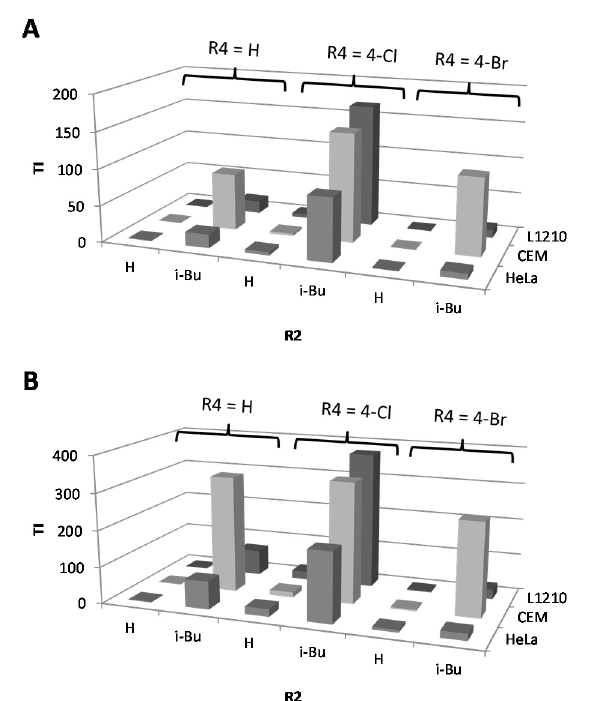
Figure 3. Effect of introduction of an iso-butyl chain at the 2 N -position (R2) of 5-Ar-2AIs, bearing H, Cl or Br at the para-position of the 5-phenylring (R4), on the therapeutic index (TI) with respect to Salmonella Typhimurium biofim inhibition ( A ) and Pesudomonas aeruginosa biofilm inhibition ( B